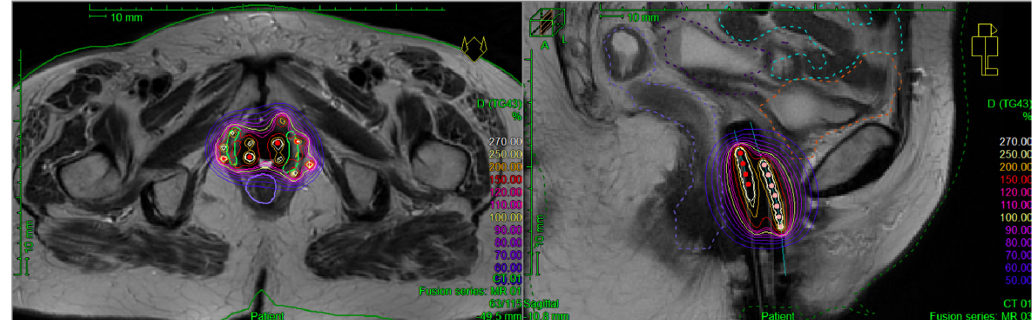
Figure 3. Example of MRI-guided PDR BT reirradiation for vaginal recurrence . MRI-guided PDR BT reirradiation implant to a bi-focal recurrence of endometrial adenocarcinoma to the lower third of the vagina, initially treated by total hysterec- tomy, followed by pelvic EBRT (45 Gy in 25 fractions) and by HDR BT of vaginal cuff (10 Gy in 2 weekly fractions of 5